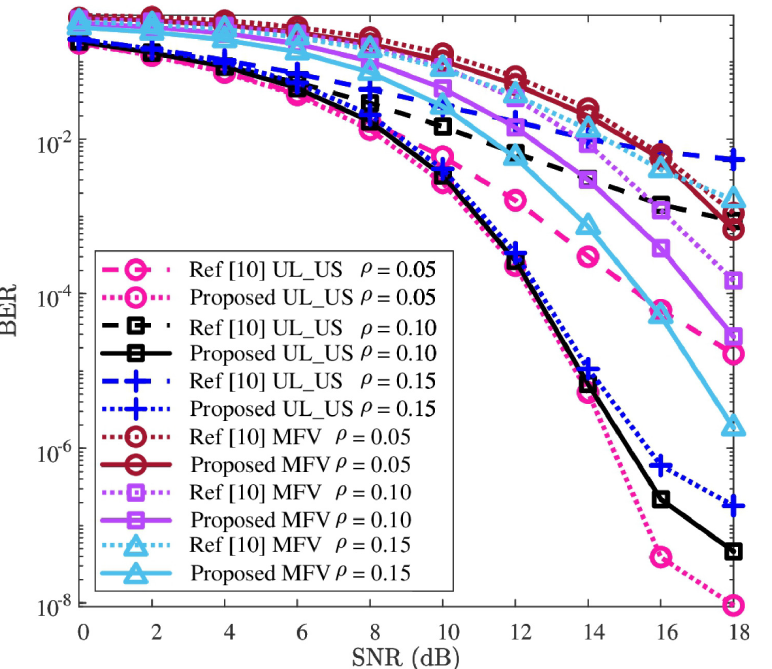
Fig 6. BER versus SNR, where P = 512 and c = 2.0 are considered.